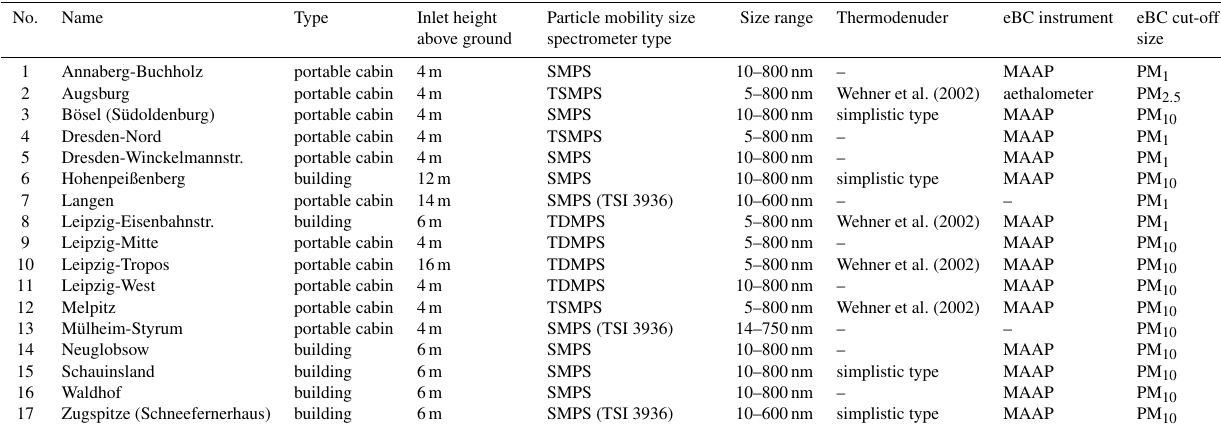
Table 2. Technical features of GUAN instrumentation. Mobility particle size spectrometers follow the TROPOS design (Sect. 4.1.1) unless stated otherwise. Two types of thermodenuders are used to measure non-volatile size distributions (Sect. 4.2). No.